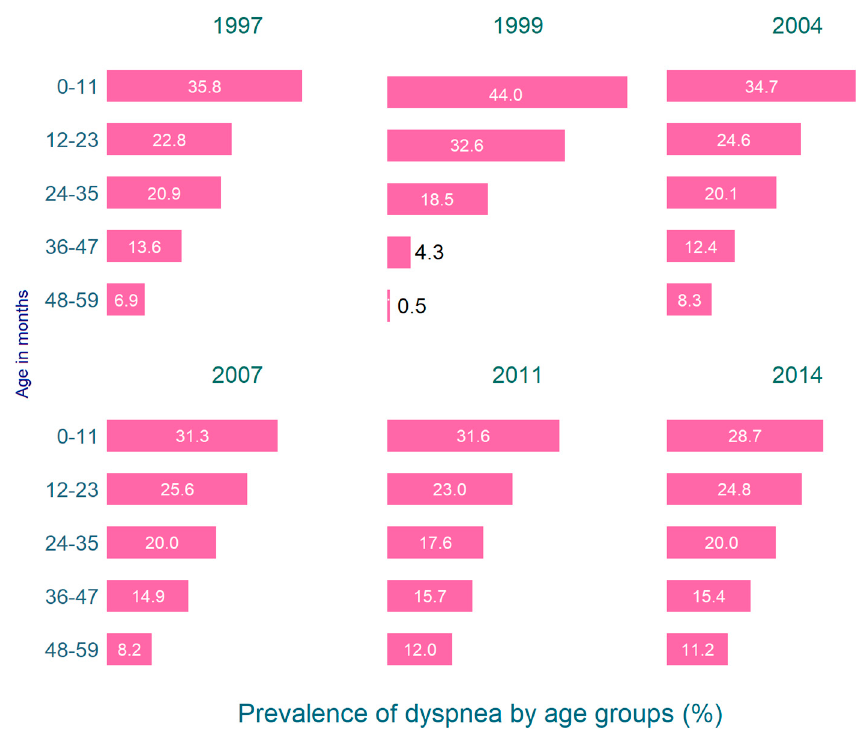
Figure 2. Prevalence of dyspnoea among under-five children in Bangladesh 1997–2014.